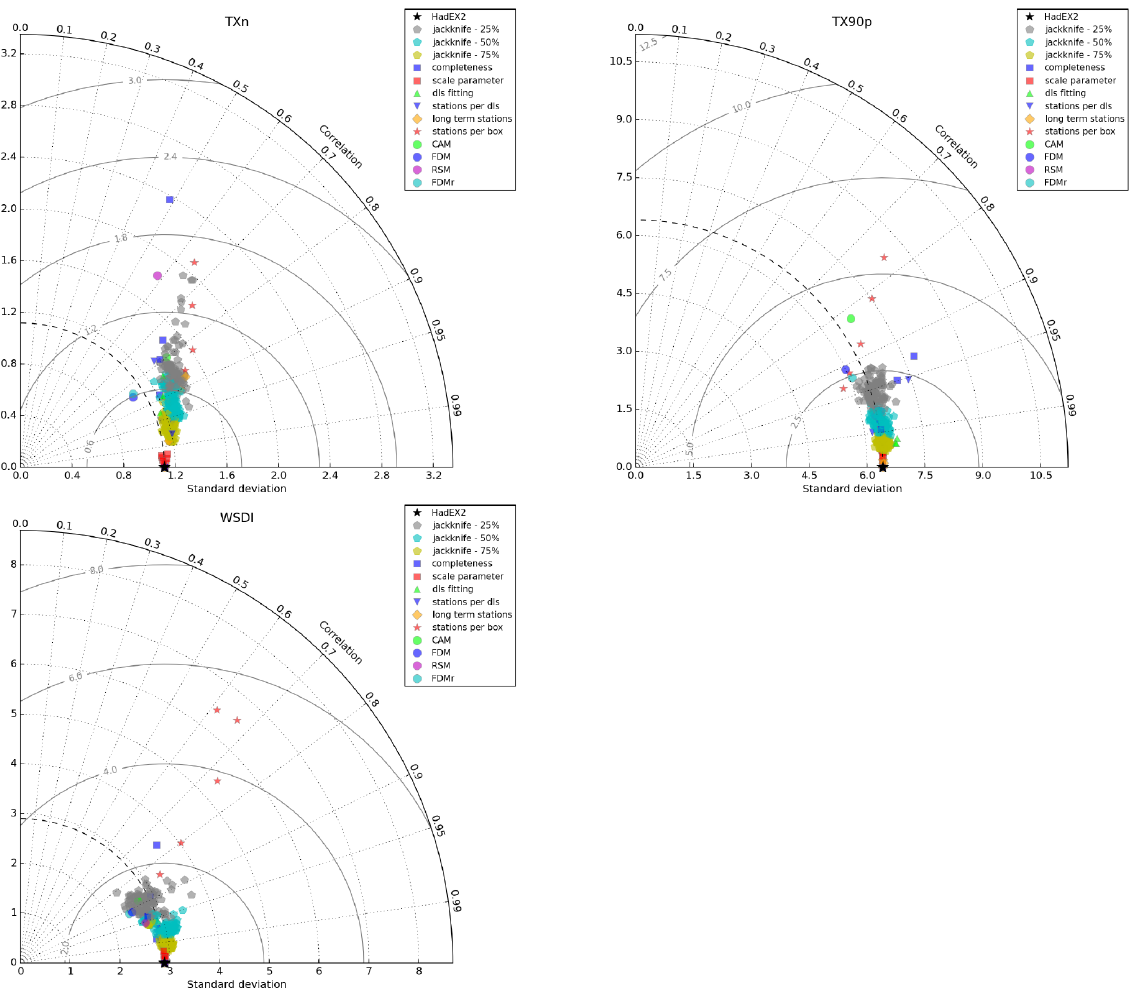
Figure 20. Continued. Diagrams for TXn (Minimum Tmax), TX90p (Tmax < 90 th percentile) and WSDI (Warm Spell Duration Indicator) are